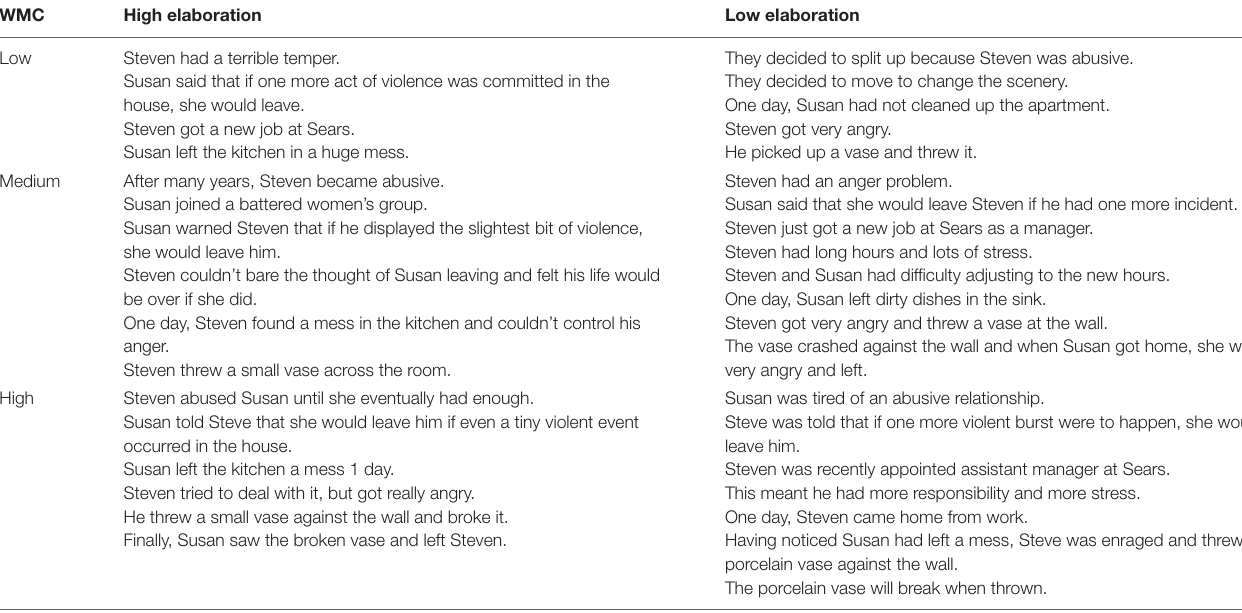
TABLE 6 | Sample recall text in low and high elaboration condition among three WMC groups. WMC High elaboration Low elaboration Low